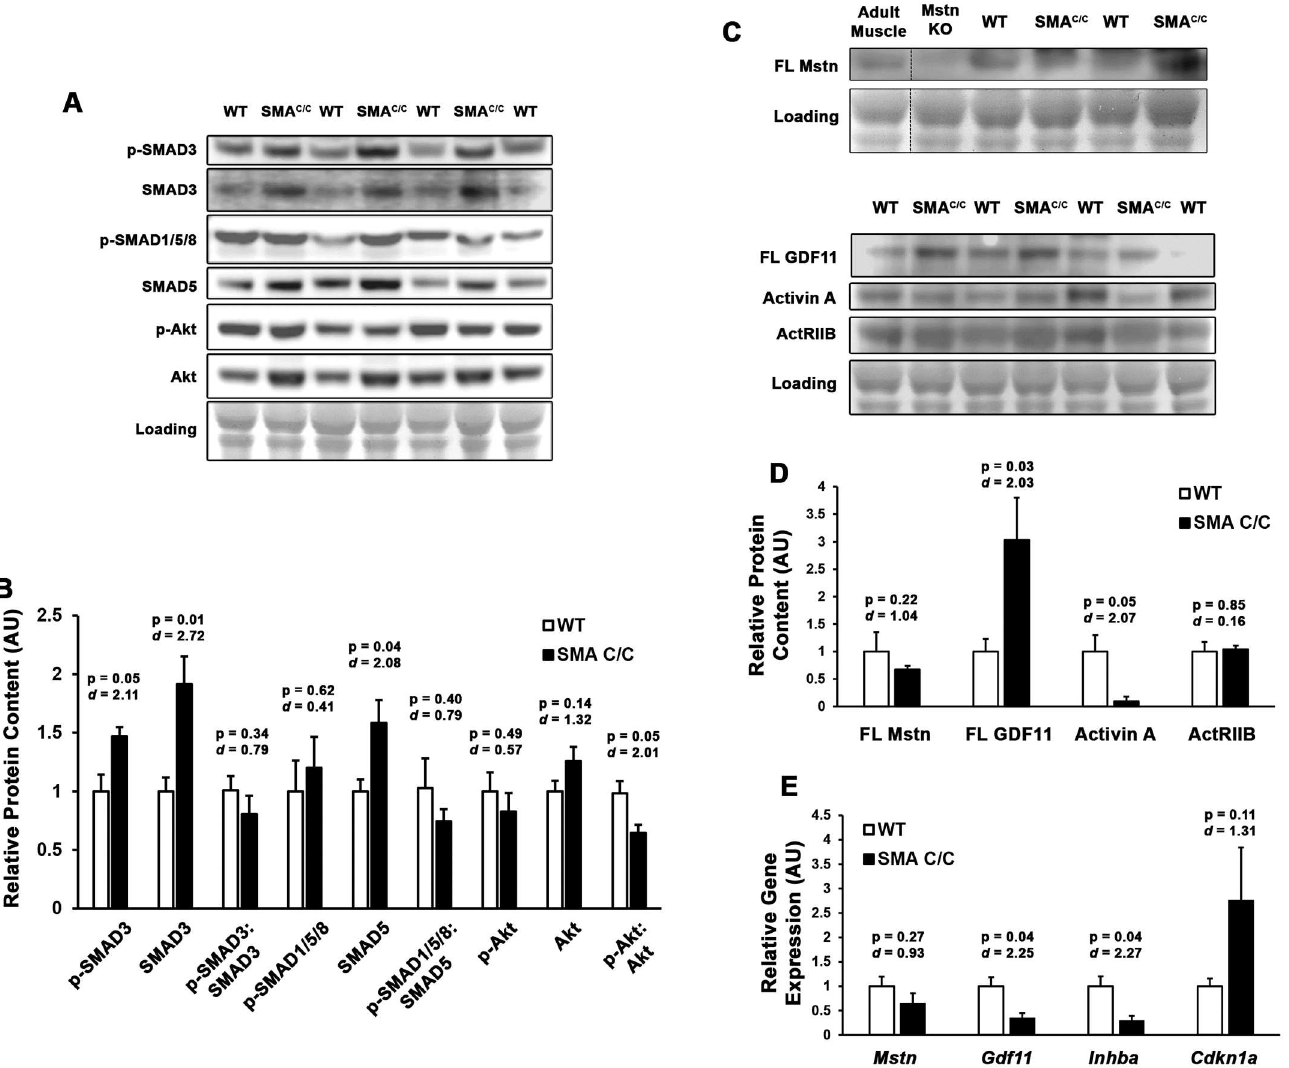
Fig 1. Hyperactivation of activin signaling pathway in young SMA C/C mouse skeletalmuscle. ( A-B ) Quadricepsmuscles from 4 week-oldSMA c/ c mice (n = 3) and wild-type (WT) littermates (n = 4) were immunoblotted for phosphorylated and total SMAD3, SMAD1/5/8, and Akt content. ( C-D ) Protein content of full-length(FL) myostatin (Mstn), FL GDF11, Activin A, and activin IIB receptor (ActRIIB) was measuredby immunoblotting IgG- depletedquadricepslystate samples. Immunoblotting quantifications are normalizedto PonceauRed-visualized loading.Adult muscle and Mstn knockout (KO) samplesare includedto demonstrate specificity of the antibody used. ( E ) Relativegene expressionof Mstn , Gdf11 , Inhba , and Cdkn1a (normalizedto Gapdh )of the 4 week-oldmouse quadriceps, as measured by real-time PCR. Data were analyzedusing Student’s T-tests, and are presentedas mean ± SEM with p-values and effect size ( d )